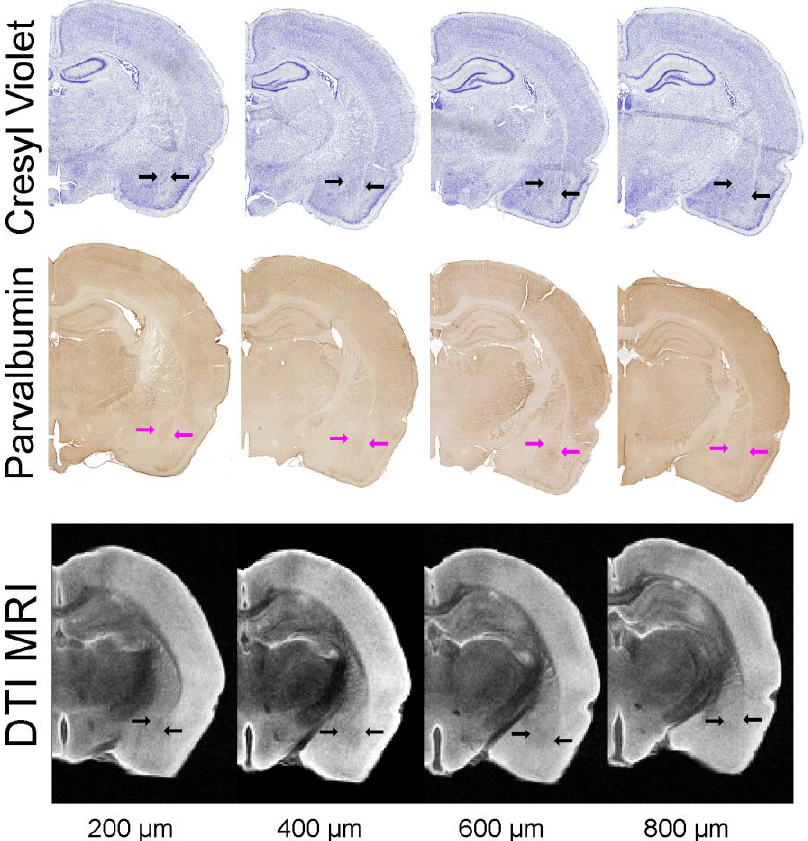
Figure 5. Histological delineation of the BLA. Histological sections (30 µm thick) were matched to MRI DTI slices (direction 11, 200 µm thick) for volumetric analysis. Cresyl violet staining and parvalbumin immunohistochemistry for BLA were utilized to derive BLA volumes. Blue and magenta arrows outline the BLA on the histology. The DTI eigenvalue images are from direction 11 with slices 200 µm apart. All data in this figure were derived from the same animal.